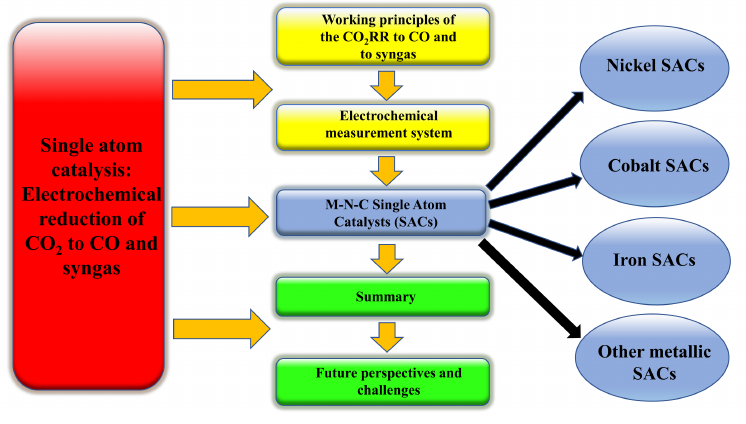
Figure 2. The outline of the